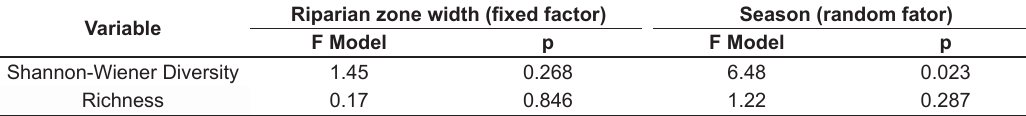
Table 5. Two-way ANOVA with fixed (riparian zone width) and random (season) factors for Shannon-Wiener diversity index and Richness of benthic macroinvertebrate assemblages.